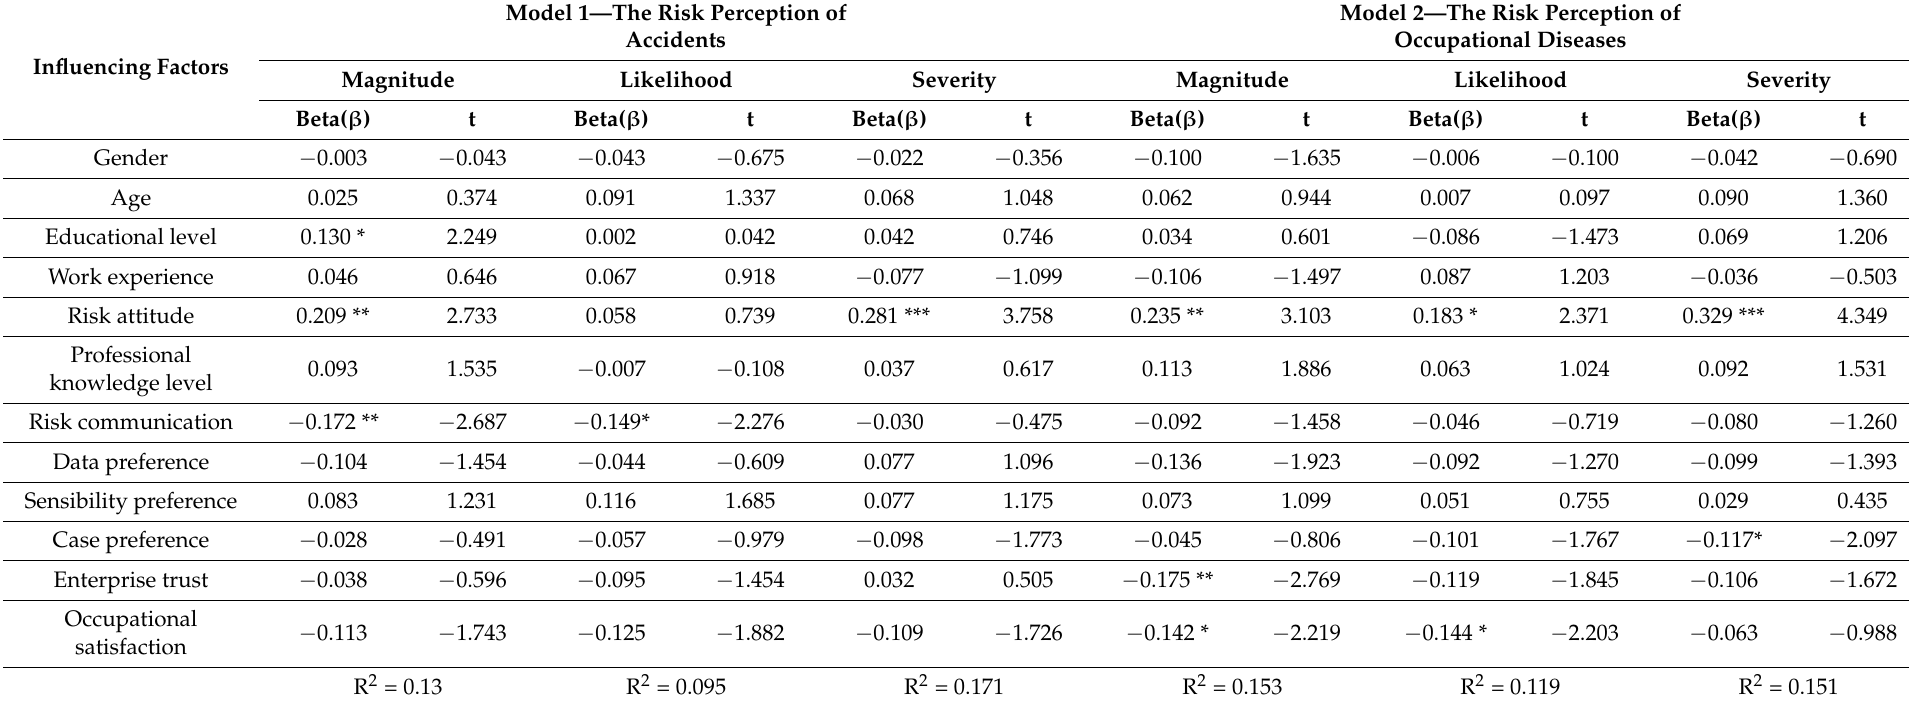
Table 8. Influencing factors of risk perceptions of accidents and occupational diseases. Model 1—The Risk Perception Influencing Factors